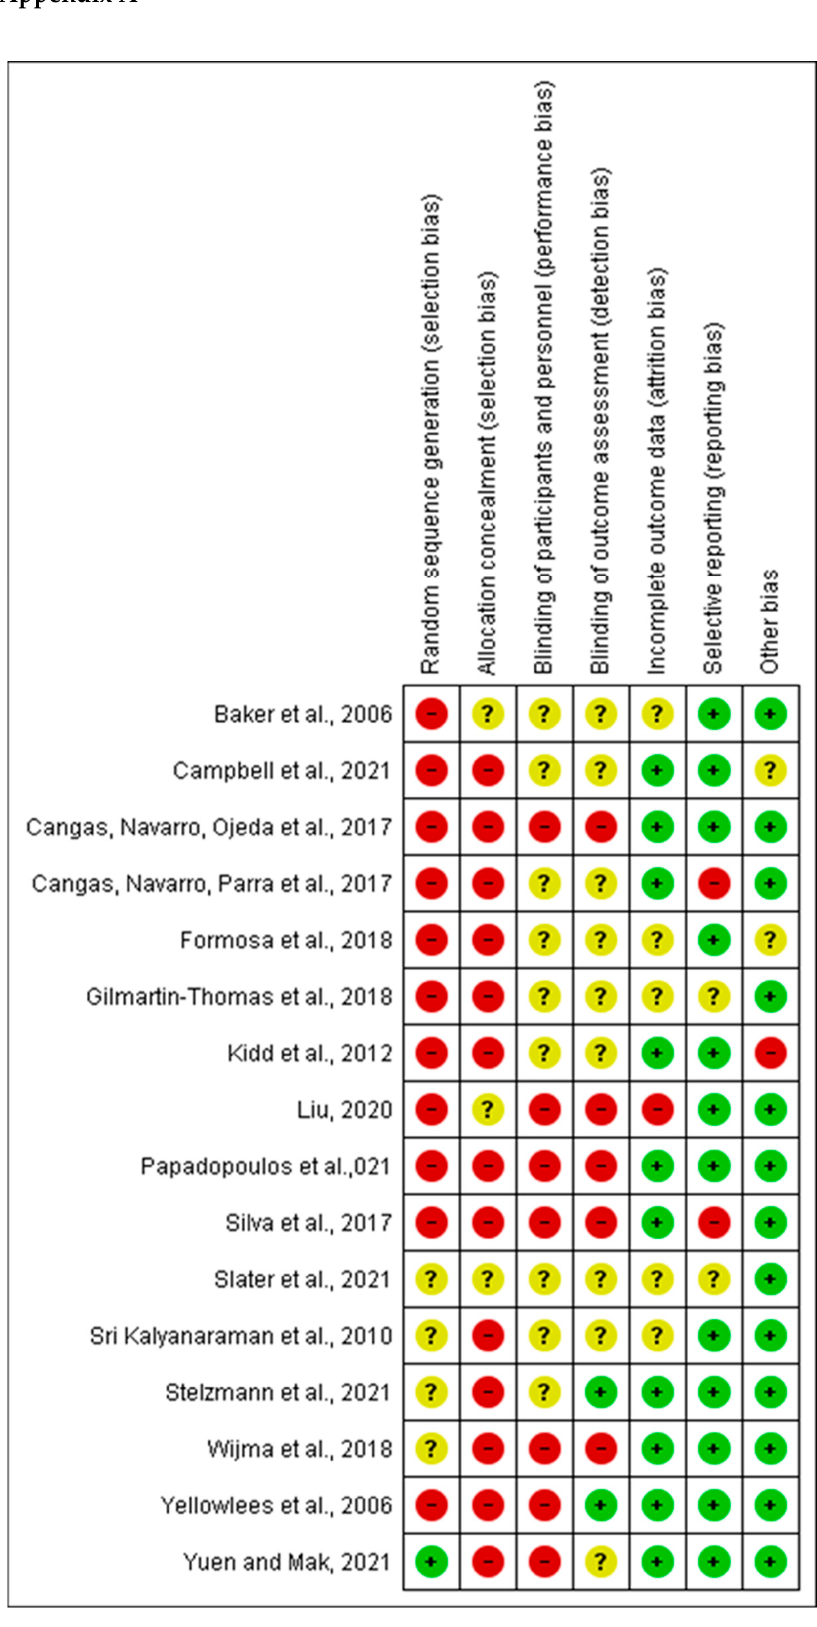
Figure A1. (+): low risk of bias, (-): high risk of bias, (?): unknown risk of bias [34–36,41–53].